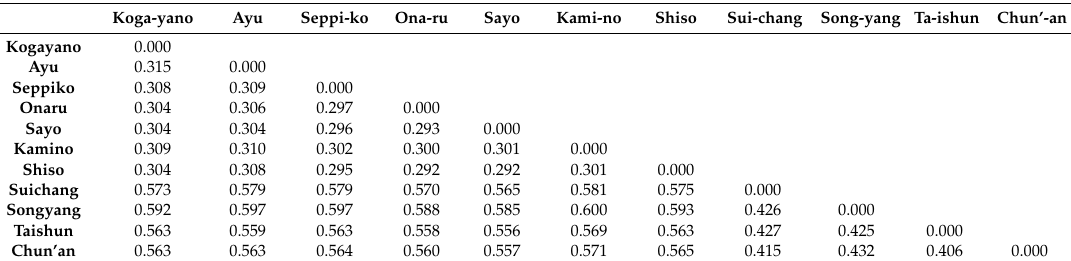
Table 1. Pairwise Population Matrix of Nei Unbiased Genetic Distance.